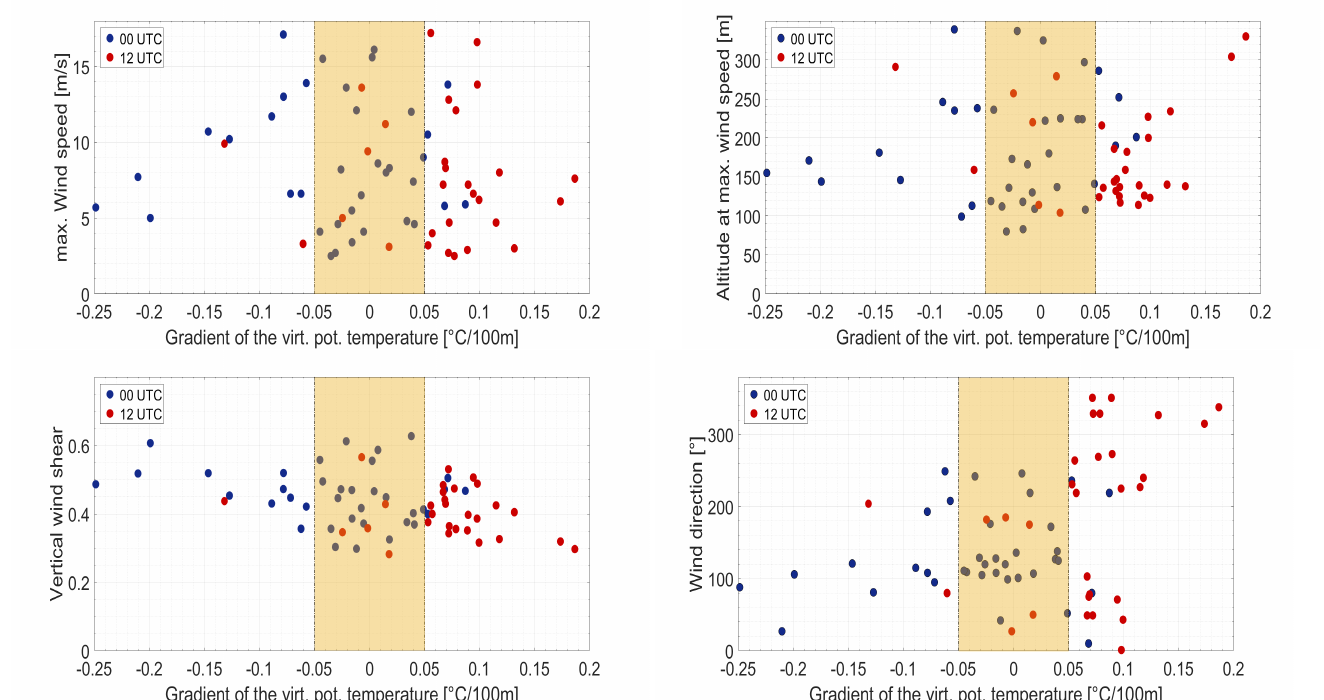
Figure 8. LLJ properties depending on the gradient of virtual potential temperature as an indicator for stability. ( upper left ) Maximum wind speed, ( upper right ) core height, ( lower left ) vertical wind shear, ( lower right ) wind direction at core hight. The radiosonde ascents at midnight are indicated by a blue symbol, the ascents at noon by a red symbol. The range of neutral atmospheric stratification is given in